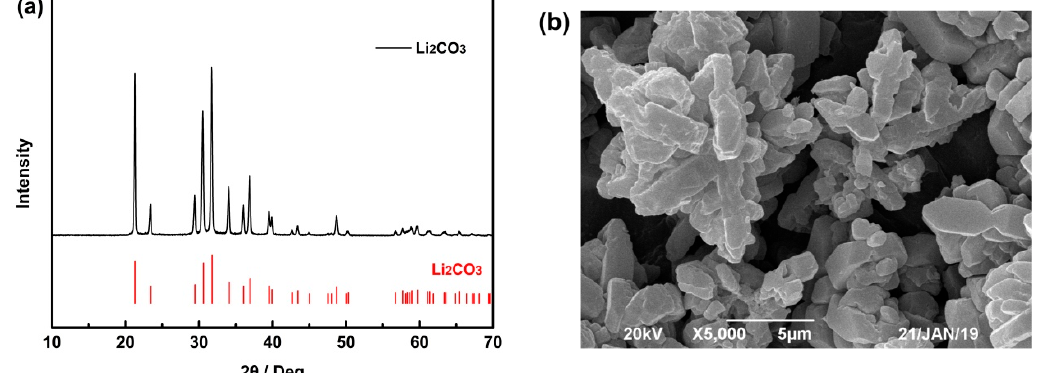
Figure 5. ( a ) XRD and ( b ) scanning electron microscope (SEM) of the obtained solid by precipitation. Table 9. The chemical composition of the prepared Li 2 CO 3 .